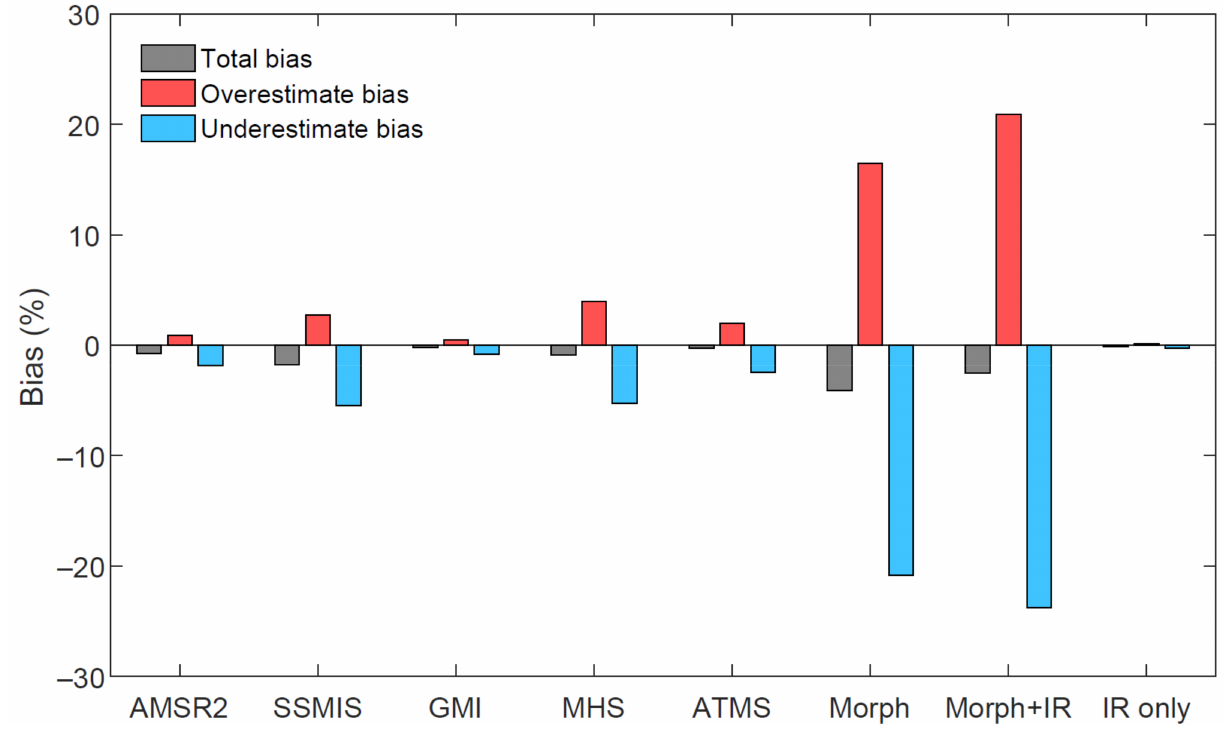
Figure 10. The total bias (TB), overestimate bias (OB), and underestimate bias (UB) components for each input source used in IMERG over the Tunxi